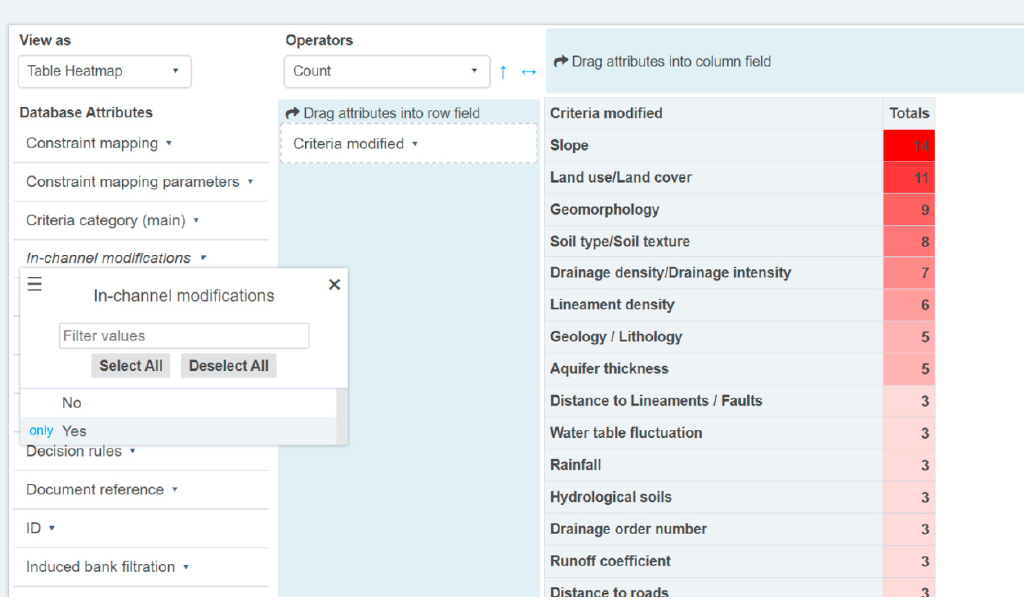
Figure 1. Interface of the database query tool showing the query for the most used criteria for the suitability mapping of in-channel modifications.